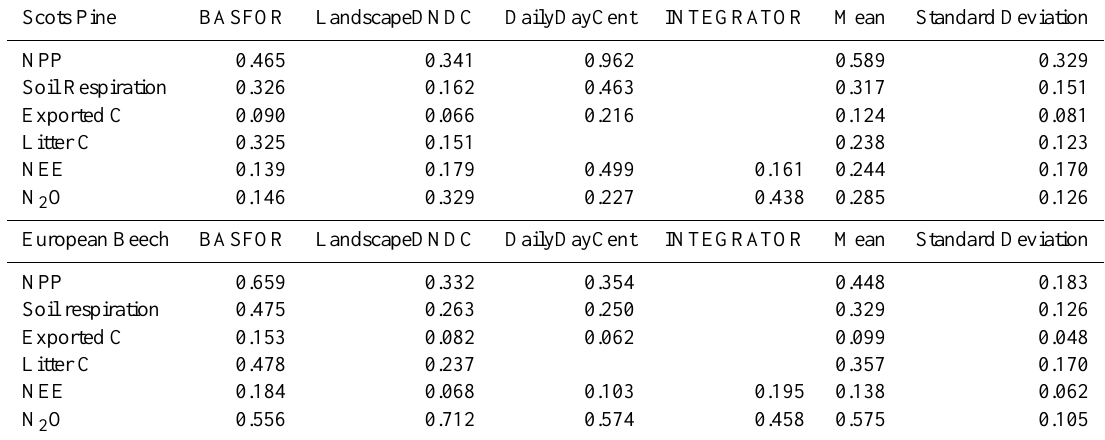
Table 4. European area weighted average values for Scots pine and European beech forests (kgCm − 2 yr − 1 ) averaged over years 2011–2020. N 2 O has units kgNha − 1 yr − 1 . Missing values in the table are where a model output was